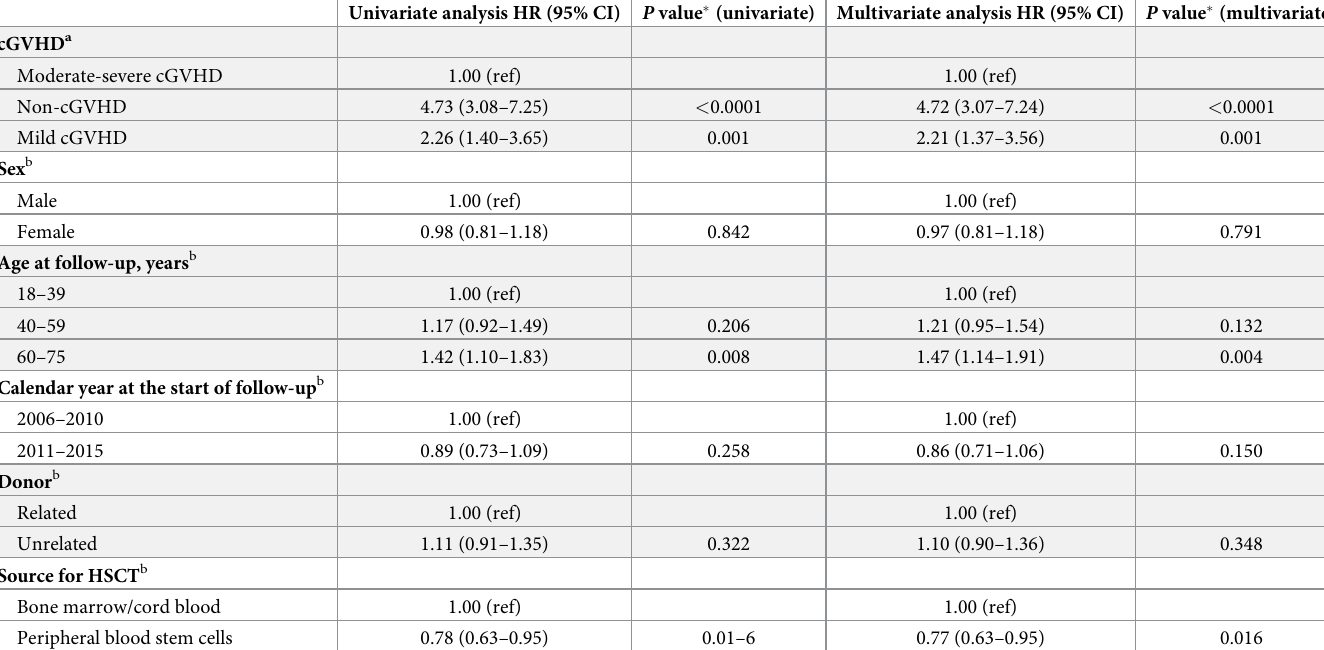
Table 3. Hazard ratios for death of patients who survived � 6 months